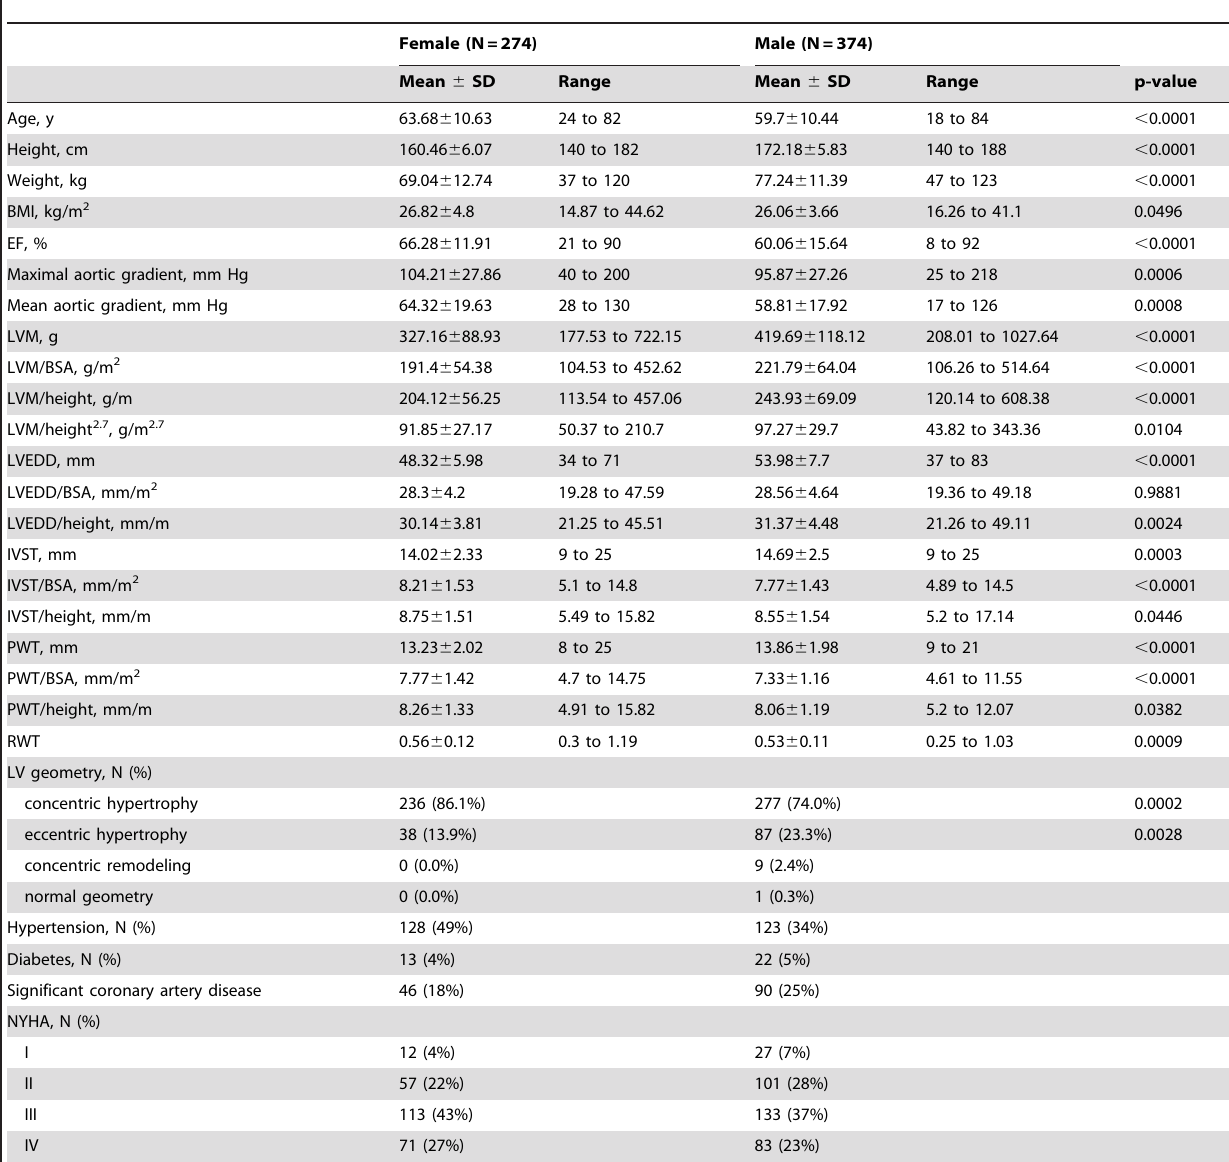
Table 1. Demographic Characteristics and Echocardiographic Data for Patients With Aortic